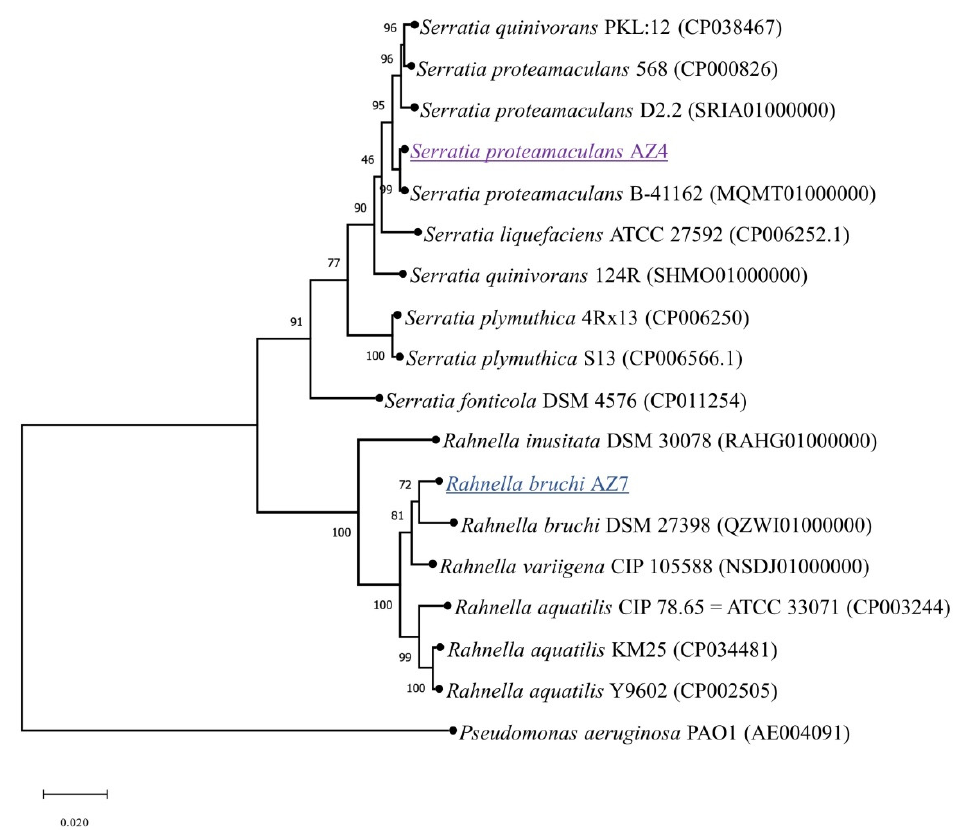
Figure 7. Phylogenetic tree of the newly isolated strains Serratia proteamaculans AS4 and Rahnella bruchi AS7 based on the partial sequences of 16S rDNA, and two housekeeping genes: CTP synthase ( pyrG ) and subunit beta of RNA polymerase ( rpoB ). Branching percentage values were determined with the use of 1000 bootstraps phylogeny test. The accession number for genomes are shown in brackets. The tree was constructed using the maximum likelihood method. The scale bar represents 1% nucleotide sequence divergence.